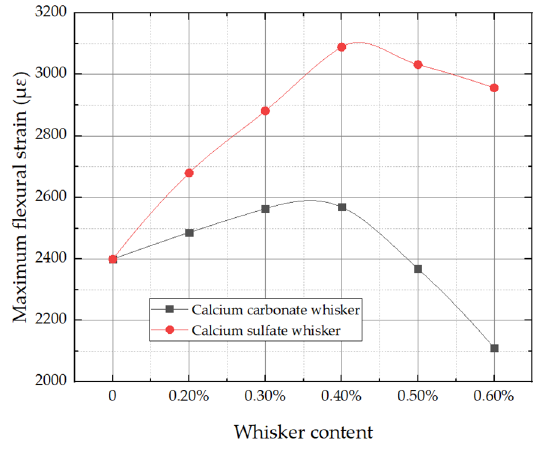
Figure 5. Maximum flexural strain test results.